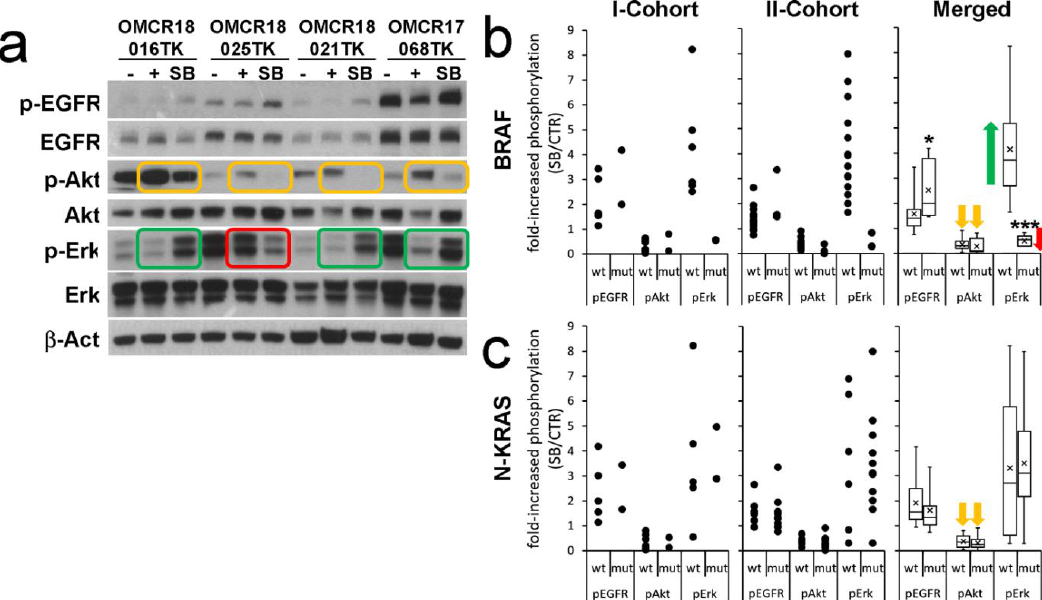
Figure 2. The biochemical signature of SB202190 (SB) on key transducers of the EGFR pathway identifies BRAF-specific modulations of p-Erk1-2. ( a ) An example of the WB analysis of four samples; − control of basal activation (48 h old medium), + positive control (new culture medium incubated for 2 h), SB (new culture medium incubated for 2 h with 10µM SB202190). Green rectangles highlight p-Erk1-2 modulation in BRAF wild-type organoids; the red rectangle indicates p-Erk1-2 in a BRAF- mutated organoid (OMCR18-025TK BRAF V600E). Orange rectangles highlight the inhibition of Akt phosphorylation. ( b ) Analysis of the fold increase in phosphorylation of EGFR, Akt and Erk1-2 in BRAF wild-type (wt) or -mutant (mut) organoids. Single cohorts (dots) and merged results (boxes) are reported. The green arrow indicates the powerful upregulation of p-Erk1-2 signaling induced by SB202190 in BRAF wt organoids as compared to its downregulation in BRAF-mutated ones (red arrow). The orange arrows indicate the inhibition of Akt phosphorylation by SB202190 in all samples. ( c ) Same conditions reported in b, comparing NRAS or KRAS (N-KRAS) wild-type and mutated organoids. Statistics: * p ≤ 0.05; *** p ≤ 0.001; n = 25.